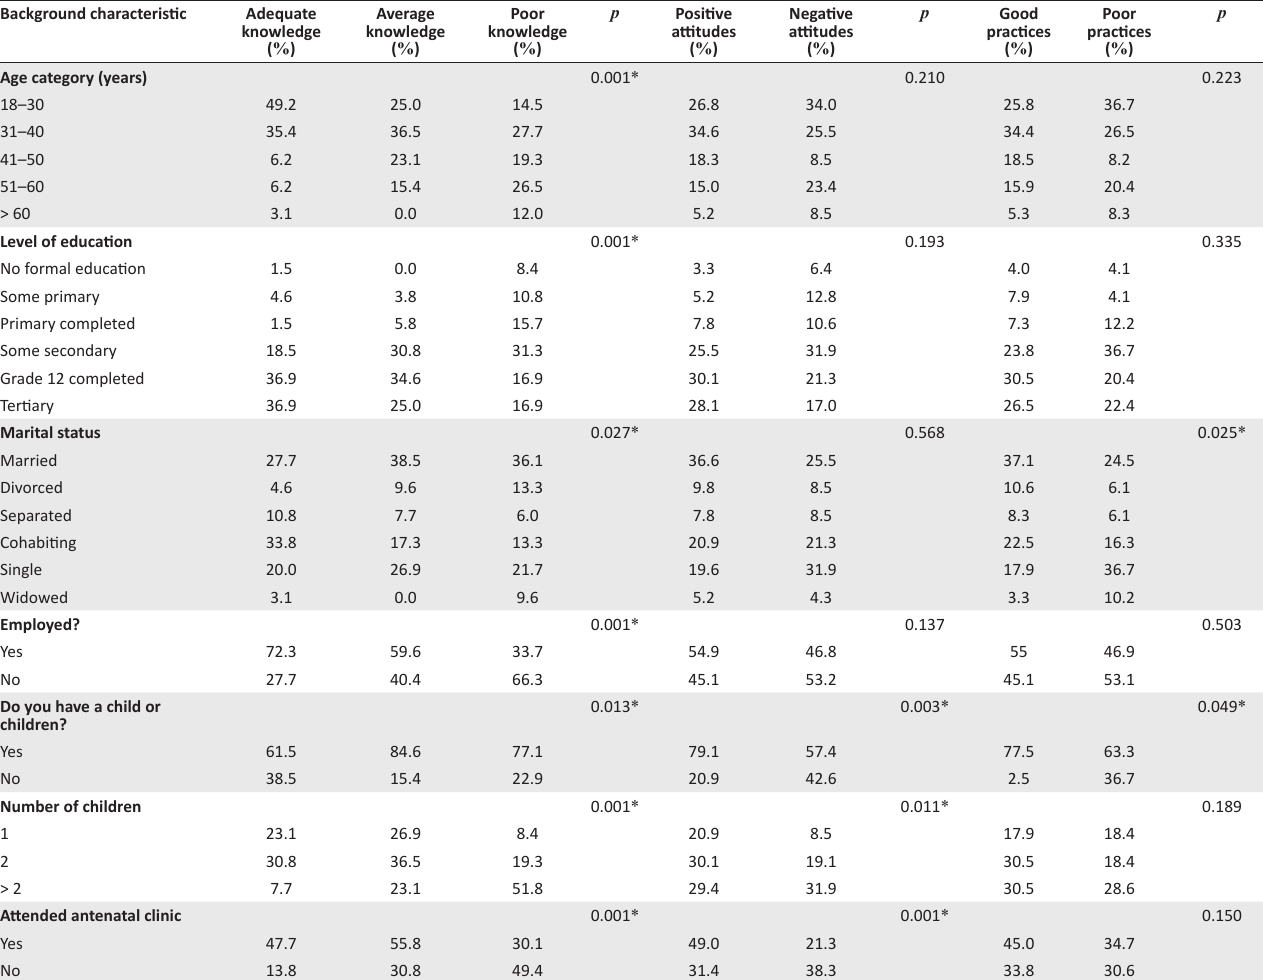
TABLE 6: Association between sociodemographic characteristics and knowledge, attitudes and practice of exclusive breastfeeding by the participants. Background